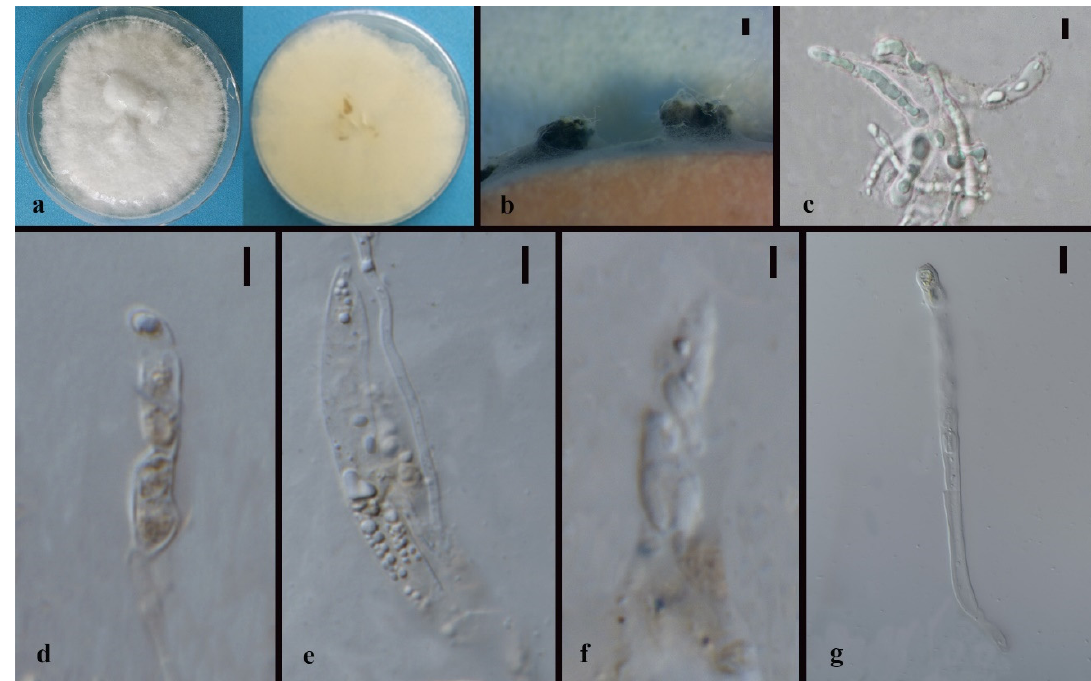
Figure 5. Annulohypoxylon moniliformis (MFLU-O35L22) ( a ) Colony on PDA (left-front view, right- reverse view). ( b ) Ascomata on WA (slide cultre). ( c – g ) Asci with ascospores on the robber band (for supporting slide) in slide culture. Scale bars: ( b ) = 200 μ m, ( c – g ) = 10 μ m.